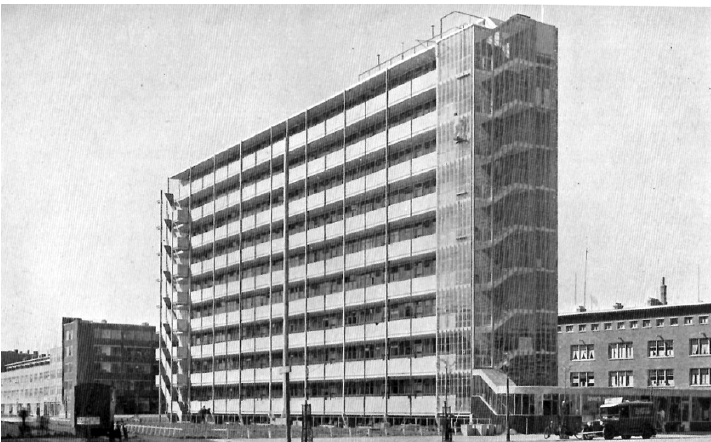
Figure 6. Willem van Tijen, with Brinkmann and Van der Vlugt, Bergpolderflat, Rotterdam, 1932–34. The first built high-rise slab by a CIAM member, and a model for the many gallery access post-war slabs of British and later housing estates. Source: Yorke & Penn (1939, plate 15).